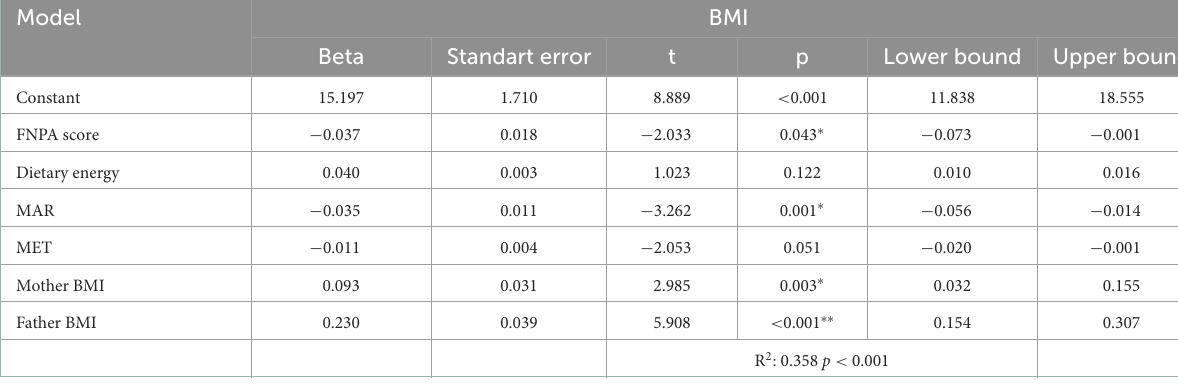
TABLE 5 Multiple linear regression analysis for children’s BMI prediction.